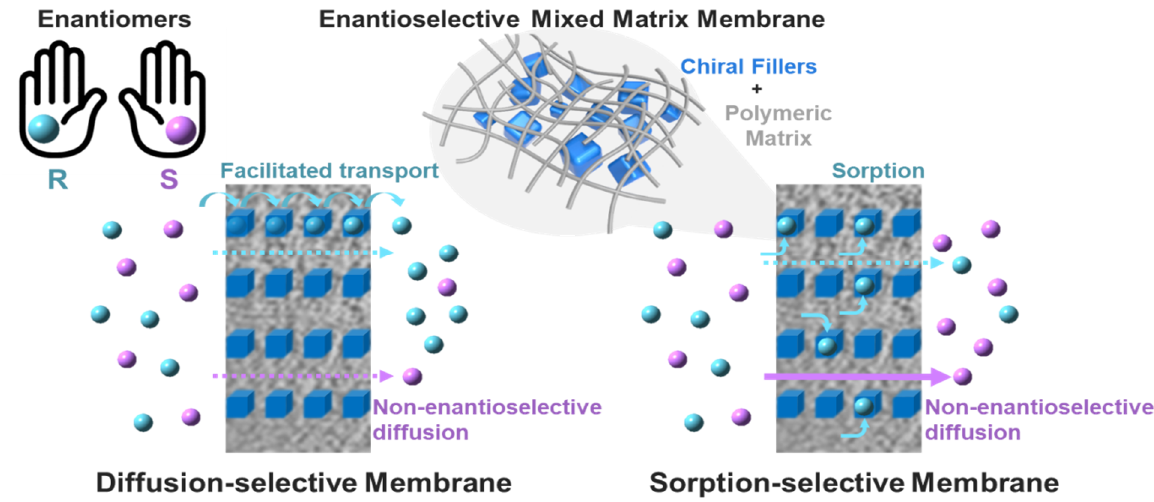
Figure 1. Schematic diagram of principles between a diffusion—elective membrane and sorption–selective membrane.